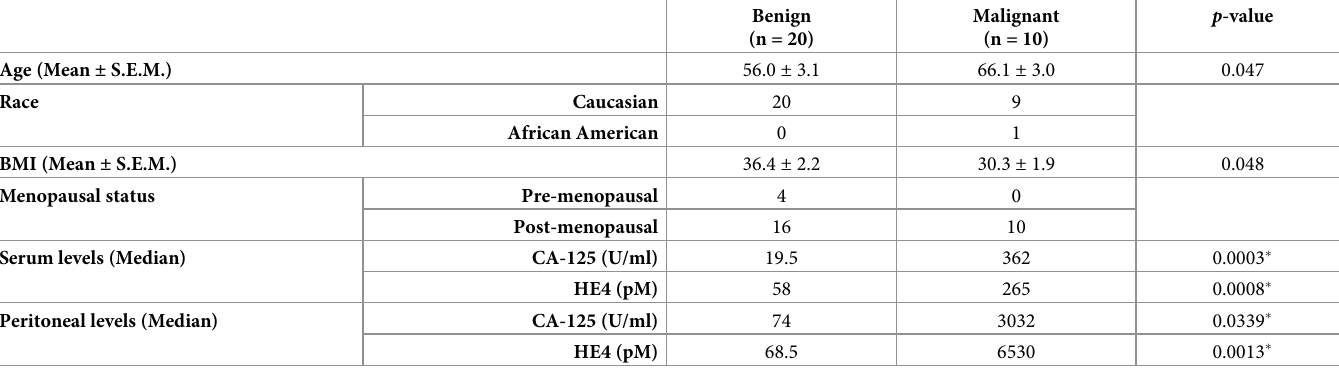
Table 1. Study population’s demographic information and tumor marker levels. Tumor markers values were compared using non-parametric Mann-Whitney test. All other numerical variables were compared through Student’s t-test.